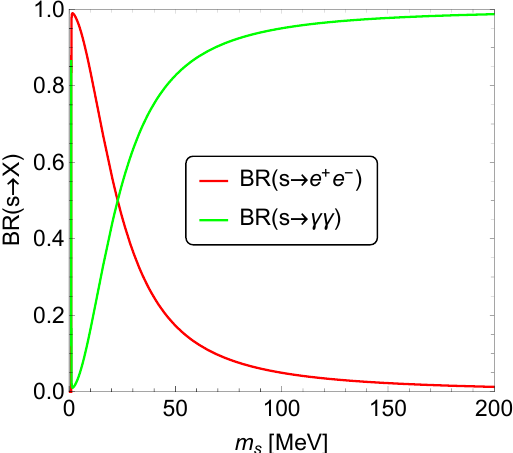
p p F = 5 (cid:2) 10 4 GeV, A 0 = F = 0 : 2). The